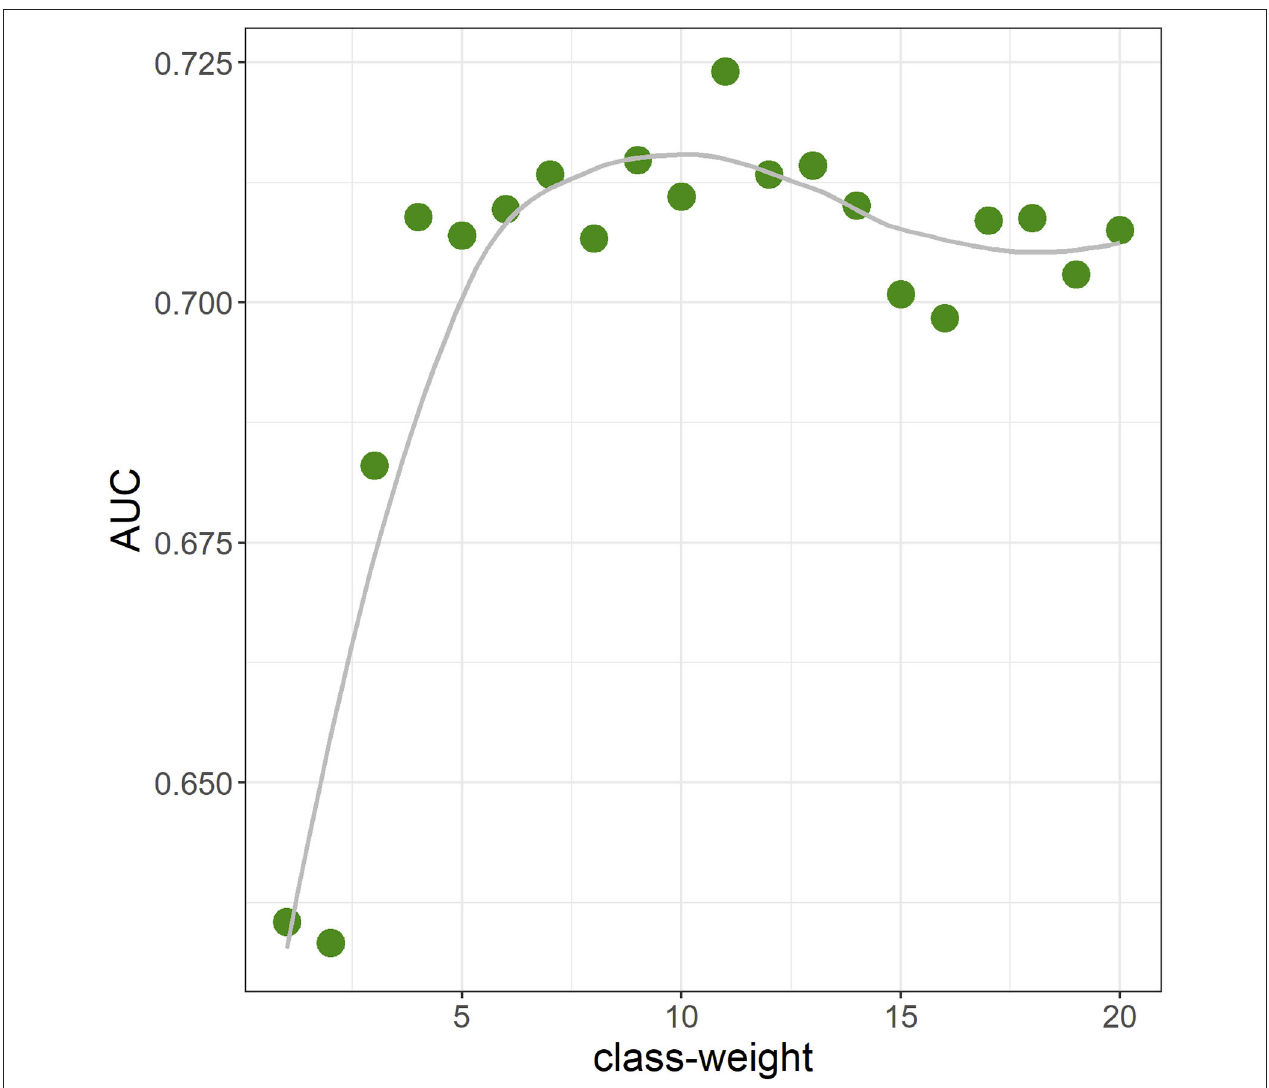
FIGURE 4 | Area-under-the-curve (AUC) when the class-weight was moved from 1 to 20 in one-value increments (10-fold cross validation). Other hyperparameters were fixed at the final